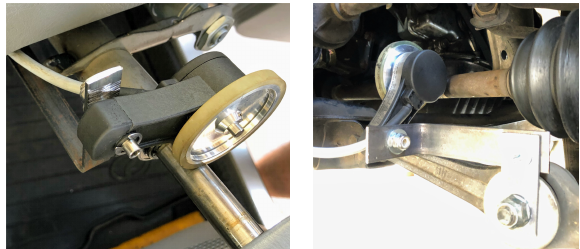
Figure 4: Rotary encoder configuration on steering column and drive shaft